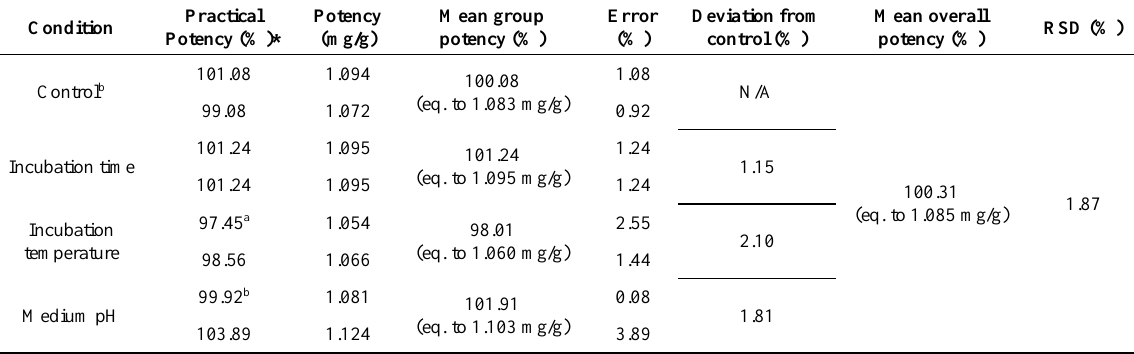
Table 5. Robustness assessment results of Gentamicin Sulfate in large assay plates for two-dose